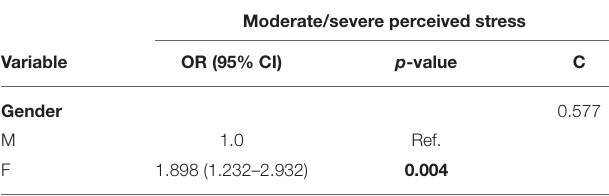
TABLE 4 | Crude OR using univariate logistic